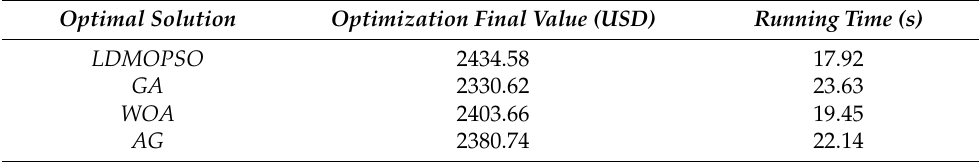
Table 3. Comparison of the operation process of the four